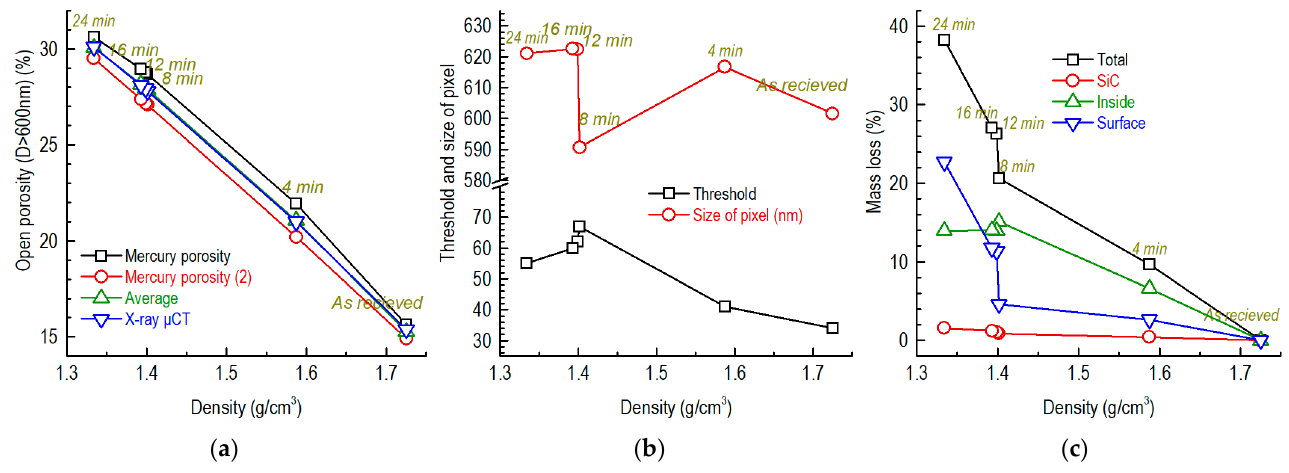
Figure 10. Open porosity, mass loss and related parameters versus density of partially SiC-coated graphite: ( a ) open porosity (D > 600 nm) versus density; ( b ) threshold and size of pixels versus density; ( c ) mass loss versus density.